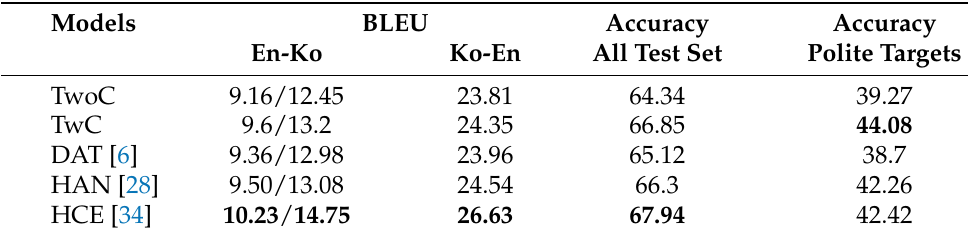
Table 2. English<->Korean BLEU scores and accuracy (%) of honorifics for context-agnostic (TwoC) and context-aware (TwC, DAT, and HCE) NMT models. English-Korean BLEU scores are shown as (normal/tokenized) respectively. All the models are trained and tested without any honorific labels or explicit control of